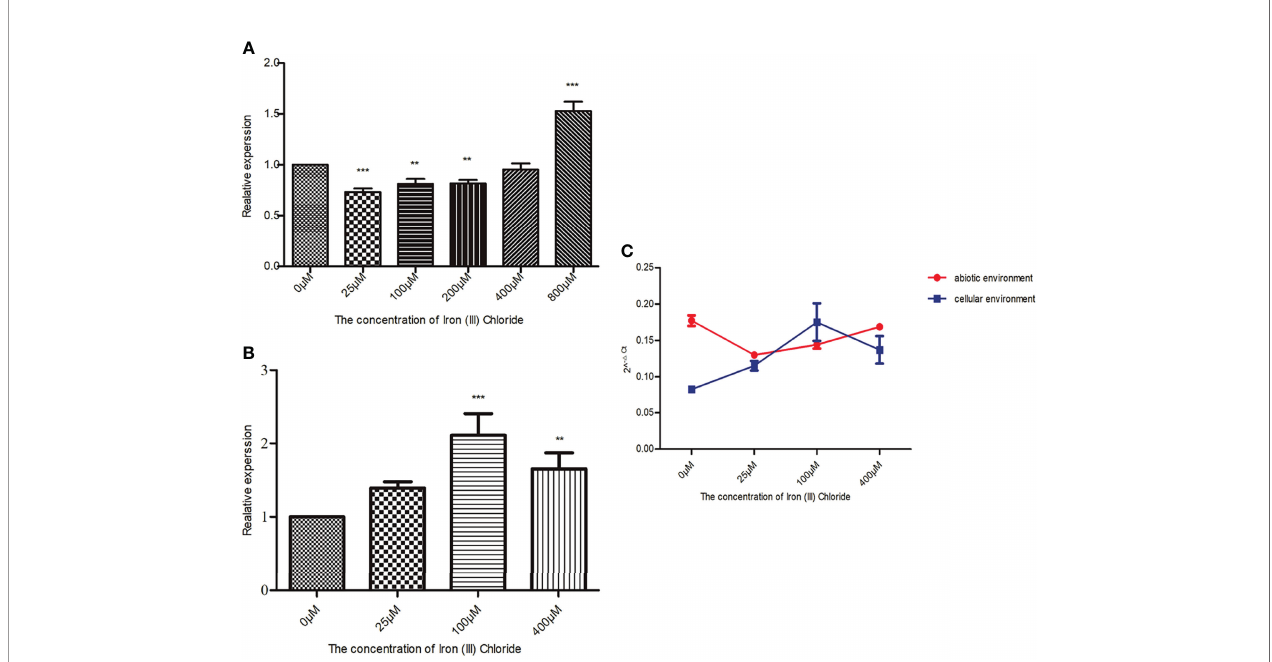
FIGURE 4 | Effect of culture conditions on Acinetobacter baumannii hcp expression. The fi nal concentrations of iron ion supplementation in the abiotic environment were as follows: 0 (iron deprivation), 25, 100, 200, 400, and 800 m M, while 0 (iron deprivation), 25, 100, and 400 m M iron ion concentrations were used in the cellular environment. The relative changes of ( A ) baumannii hcp expression in the presence of different iron ion concentrations while bacteria were cultured in the cellular or abiotic environment were calculated by the 2 − DD Ct method. gyrB gene was used as an internal reference, and hcp expression in the 0 m M group was 1. The 2 − D Ct method was used to compare the expression of hcp between the cellular and abiotic environments. (A) Effect of different iron ion concentrations on A baumannii hcp expression when cultured in the abiotic environment. (B) Effect of different iron ion concentrations on A baumannii hcp expression during A baumannii -cells ’ co- culture. (C) Changes in hcp expression in the cellular and abiotic environments. The asterisks indicate signi fi cant differences in hcp expression for bacteria in other iron ion concentration groups relative to the 0 m M iron ion (iron deprivation) group, ** p < 0.01, *** p <